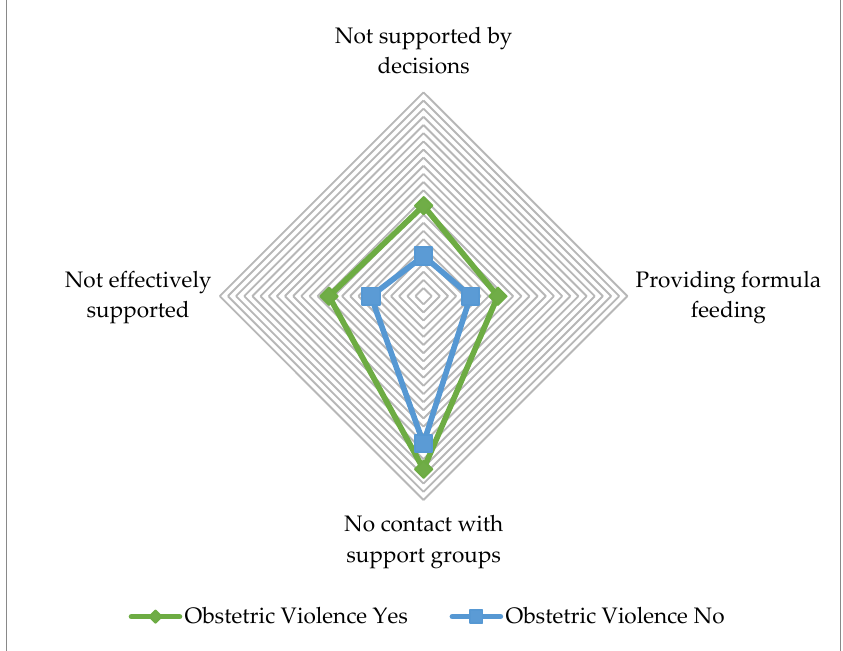
Figure 1. Comparative analysis of breastfeeding support and obstetric violence during the SARS- CoV-2 pandemic.